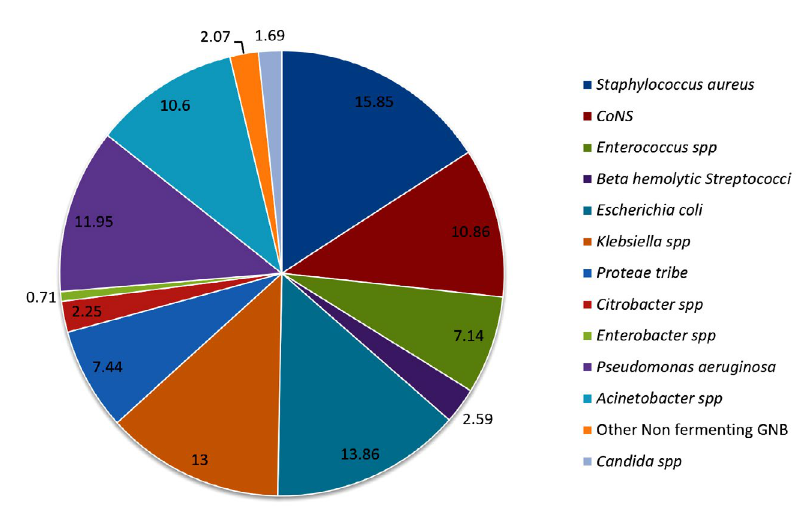
Fig. 1. Prevalence of various organisms causing SSTI in the study population